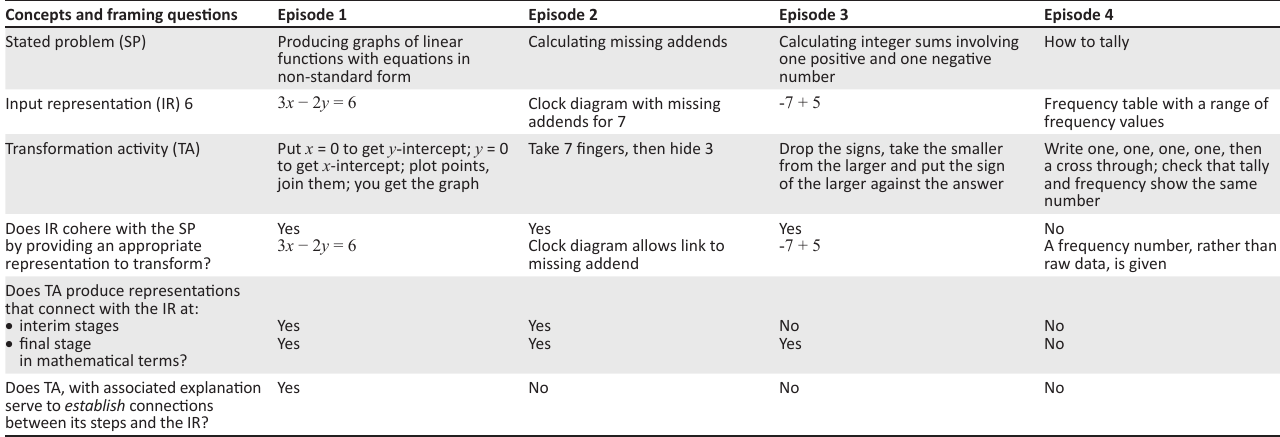
TABLE 2: Applying the analytical concepts. Concepts and framing questions